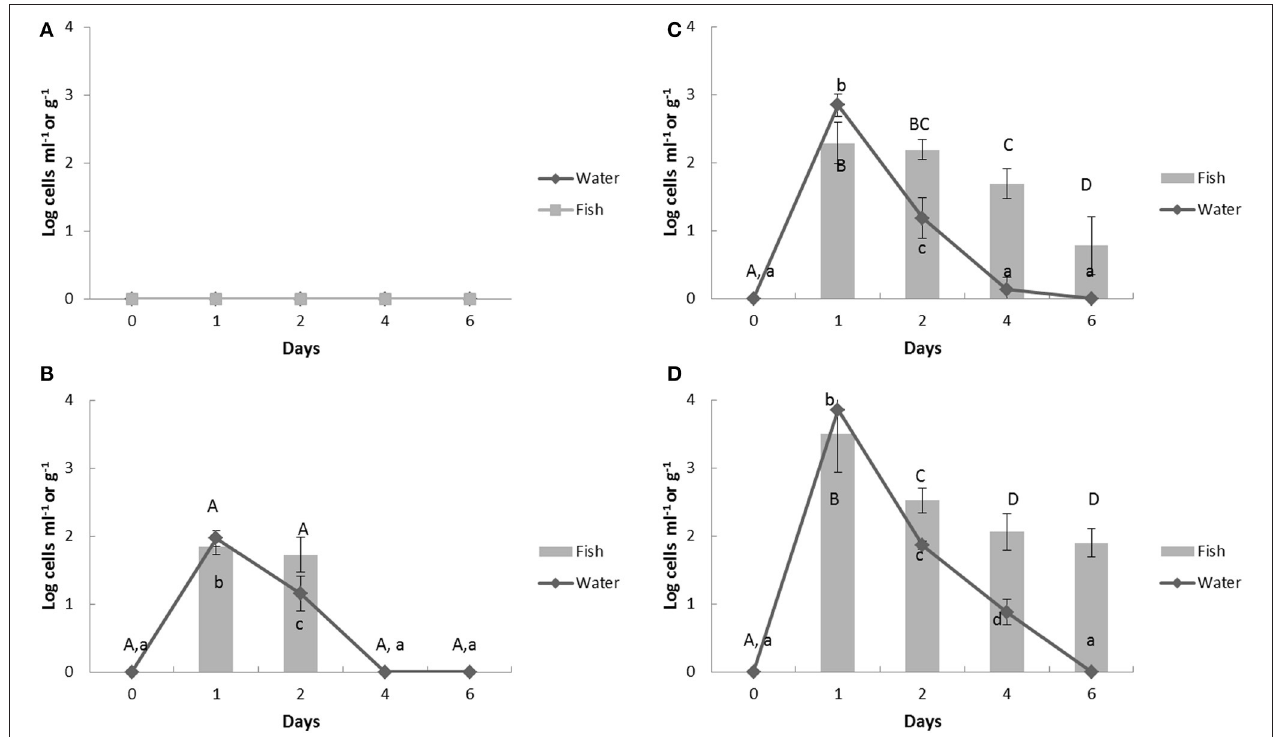
FIGURE 3 | Change of Vibrio anguillarum counts in aquaculture water and fish by multiplex real-time PCR assay in response to heat- inactivated Vibrio spp. challenge. Bold (A) control group; (B) group 2; (C) group 3; (D) group 4. The Vibrio spp. were challenged in the aquaculture water at day 1 and the samples were collected at 24 h before the challenge (day 0), 1 h after challenge (day 1), and further 2, 4, 6 days. The upper case represents significantly different grouping among fish samples and lower case shows the significant grouping between water samples by Tukey test.